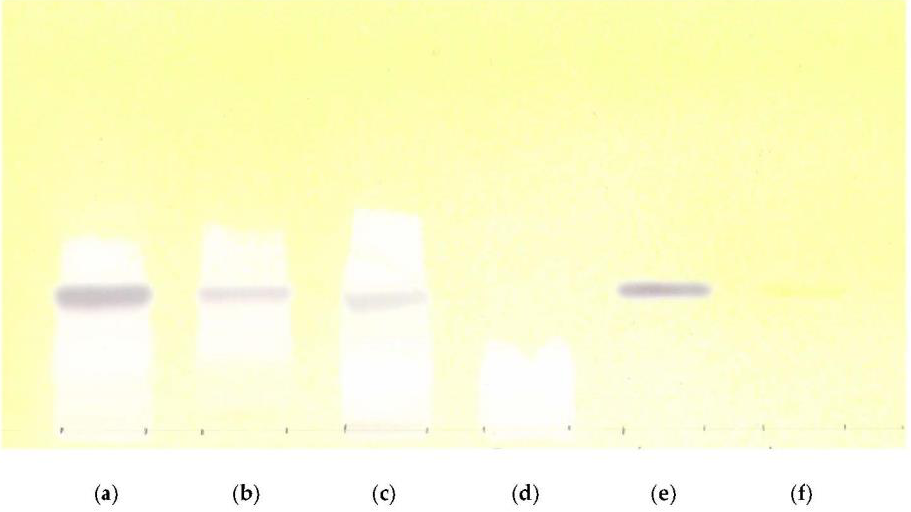
Figure 1. TLC results: ( a ) Plantago lanceolata leaf; ( b ) Plantago lanceolata dry extract; ( c ) Plantago syrup; ( d ) Placebo; ( e ) Aucubin standard; ( f ) TLC marker naphthol yellow.